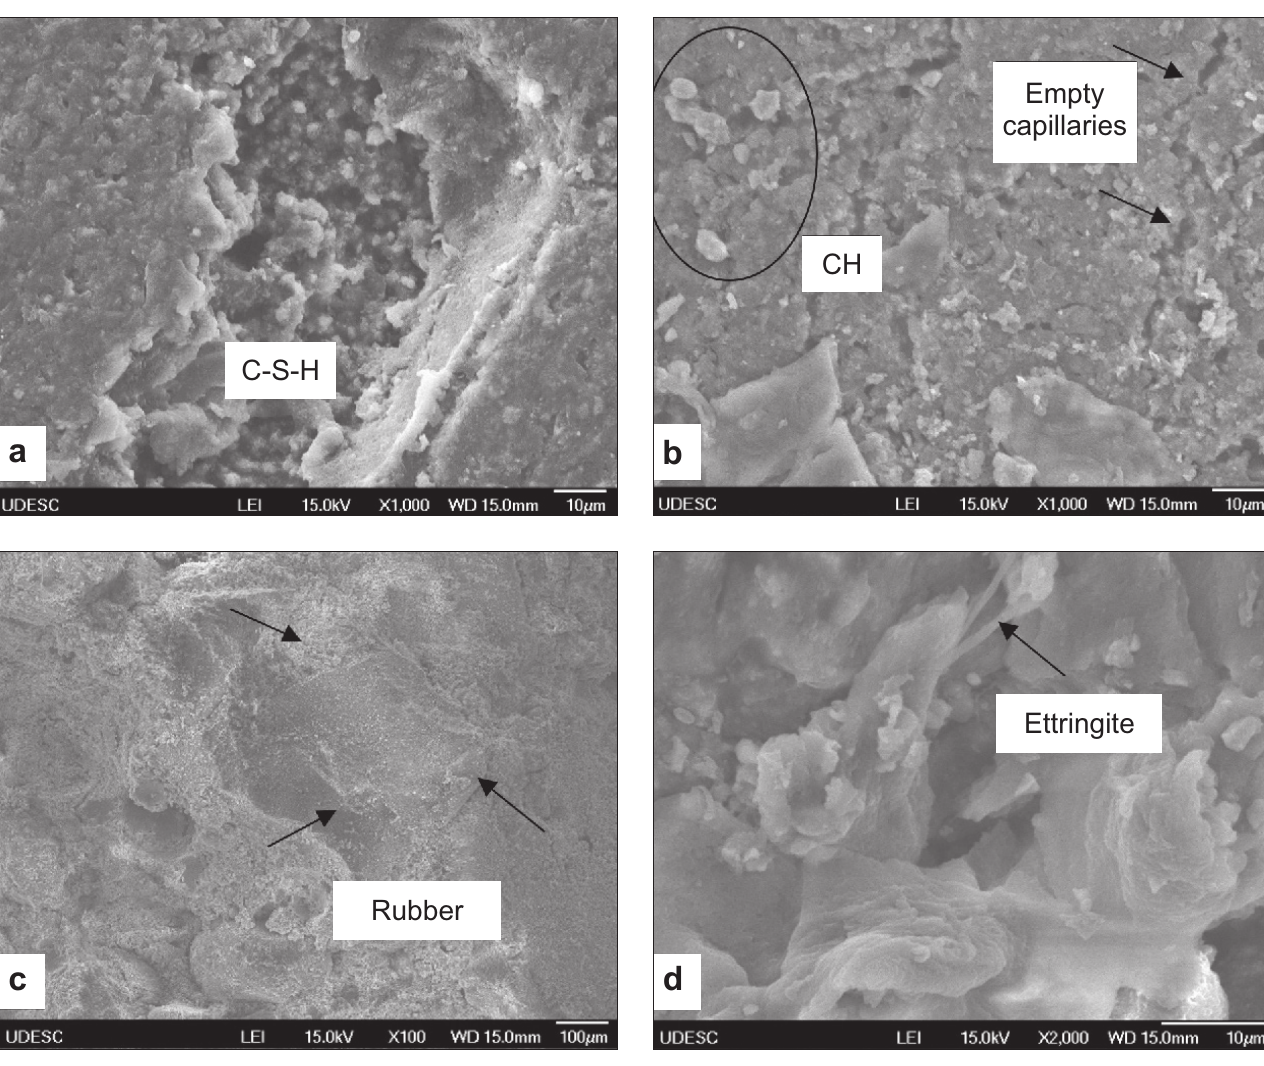
Mortar micrography, (a) formation of C-S-H, (c) formation of calcium hydroxide (CH), (c) rubber particles, (d) formation of late ettringite crystals (C